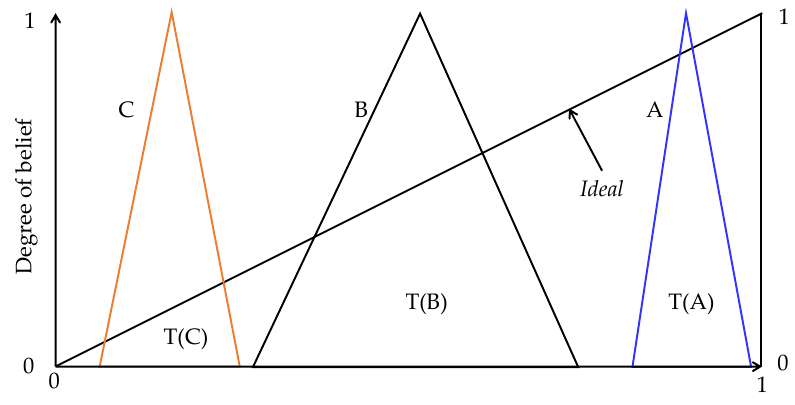
Figure 13. Comparing three alternatives using their induced fuzzy numbers.